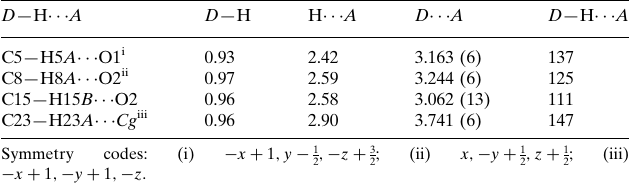
The title compound, C H BrO , is an intermediate in the 23 23 4 synthesis of fused heterocycles. In the title molecule, the cyclohexene ring has a distorted half-chair conformation. The bromophenyl ring and the mean plane of the cyclohexene ring form a dihedral angle of 13.8 (3) (cid:1) , whereas the benzene and cyclohexene rings are approximately perpendicular [88.44 (17) (cid:1) ]. There are only weak C—H (cid:2) (cid:2) (cid:2) O and C—H (cid:2) (cid:2) (cid:2) (cid:2) intermolecular interactions.